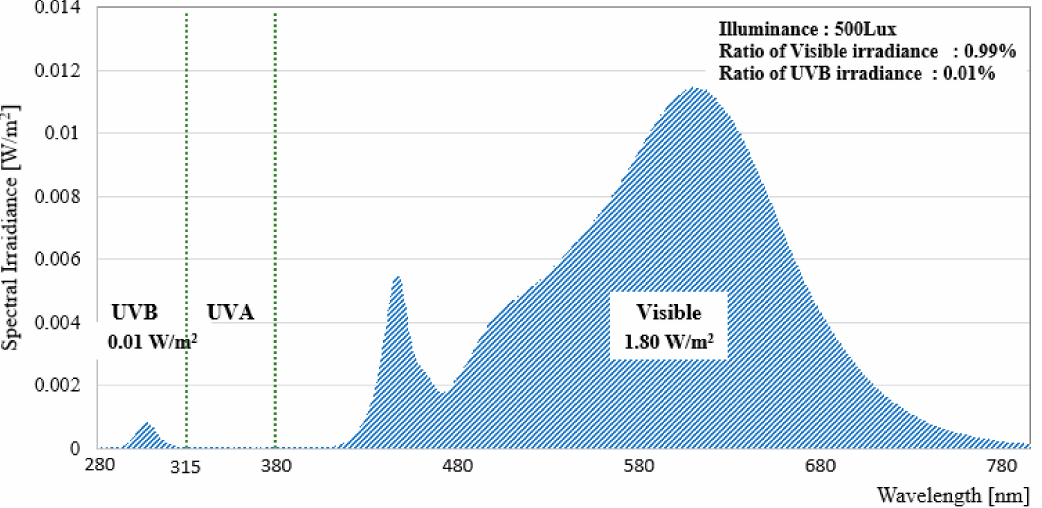
Figure 3. Spectral irradiance and light properties of UVB-LED general lighting.